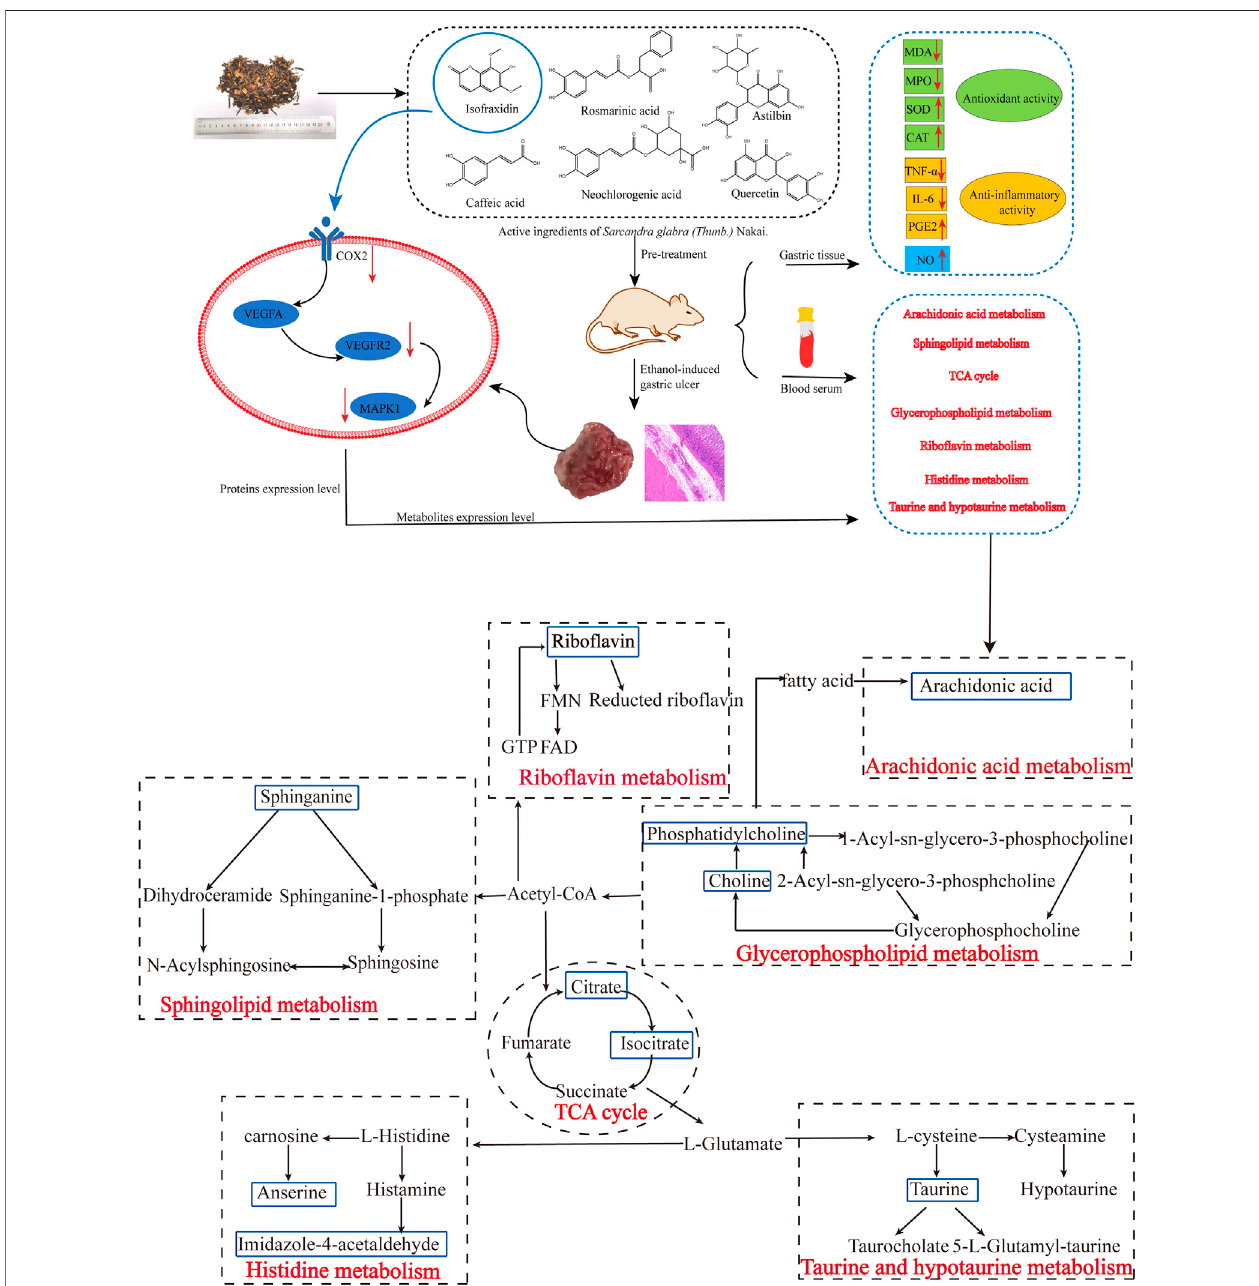
FIGURE 12 | The main mechanisms of SGN against ethanol-induced GU rats based on conjoint analysis of systems biology.